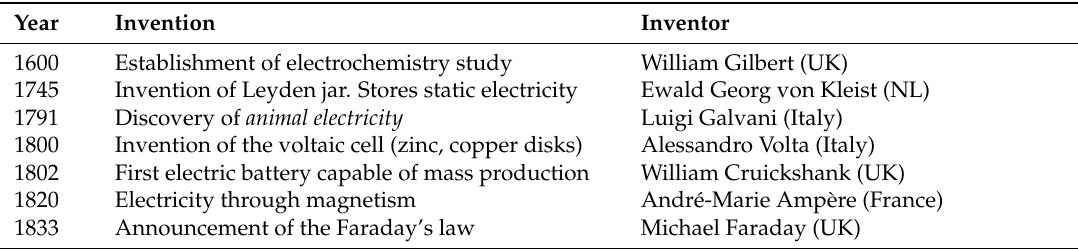
Table 1. History of battery developments